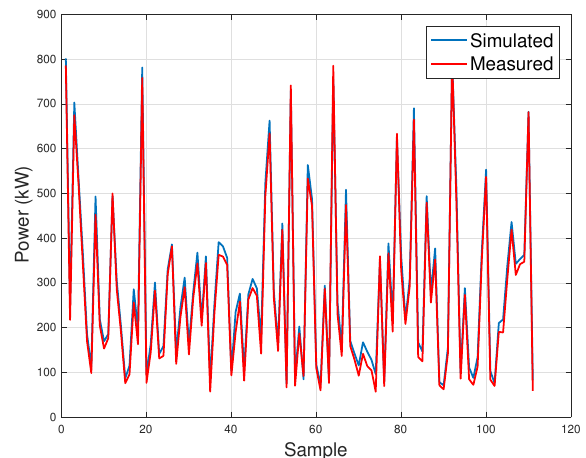
Figure 4. Simulated and measured power time series sample: D 2017 .